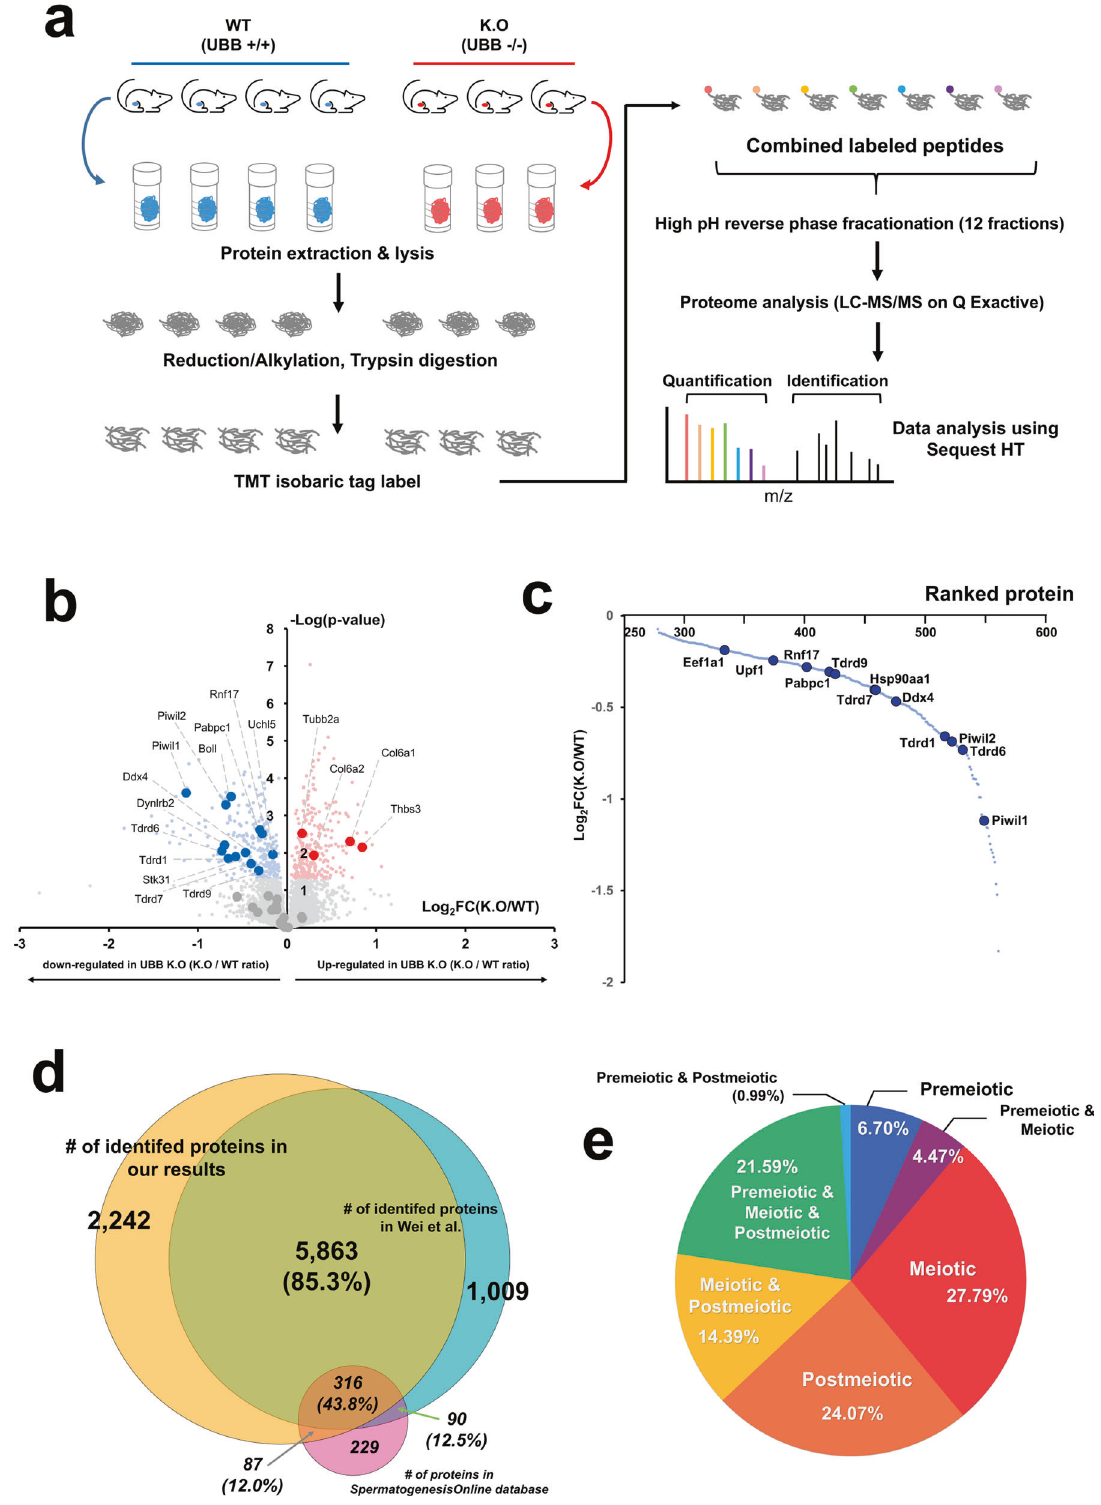
Fig. 1 Overall experimental process and global proteome pro fi ling results. a An overview of the method followed to process the tissue samples from the testis of four WT and three Ubb − / − (KO) mice for proteome analysis. b The volcano plot representation for the identi fi ed proteome and differentially expressed proteins. Red and blue dots represent signi fi cantly up- and downregulated proteins, respectively, with statistical criteria (student ’ s t -test, p -value < 0.05; red is log2fc > 1, blue is downregulated). c Protein rank plot for downregulated proteins, based on their log2-transformed fold change. d Venn-diagram for proteins in Spermatogenesis database (red circle), proteins-identi fi ed in the current study by LC – MS/MS analysis (yellow circle), and proteins-identi fi ed in Wei et al., (blue circle). e Spermatogenesis Online database- based characterization of testicular cell type of pro fi led